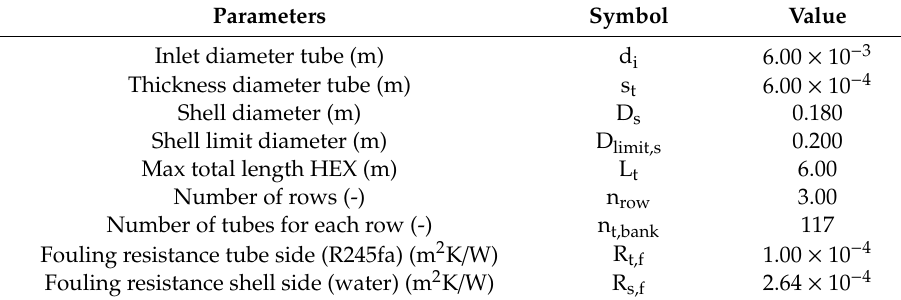
Table 4. Shell and tube heat exchanger